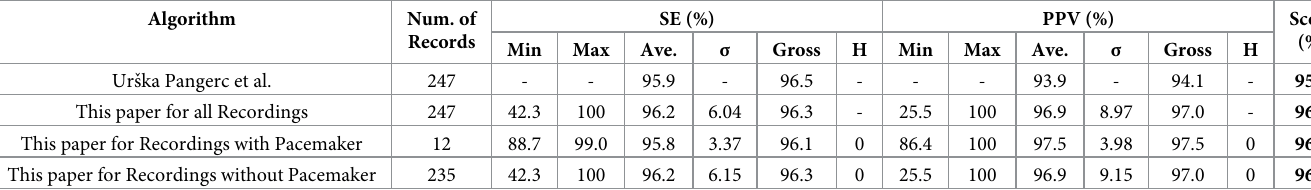
Table 2. Results of different techniques on the MGH/MF waveform database.